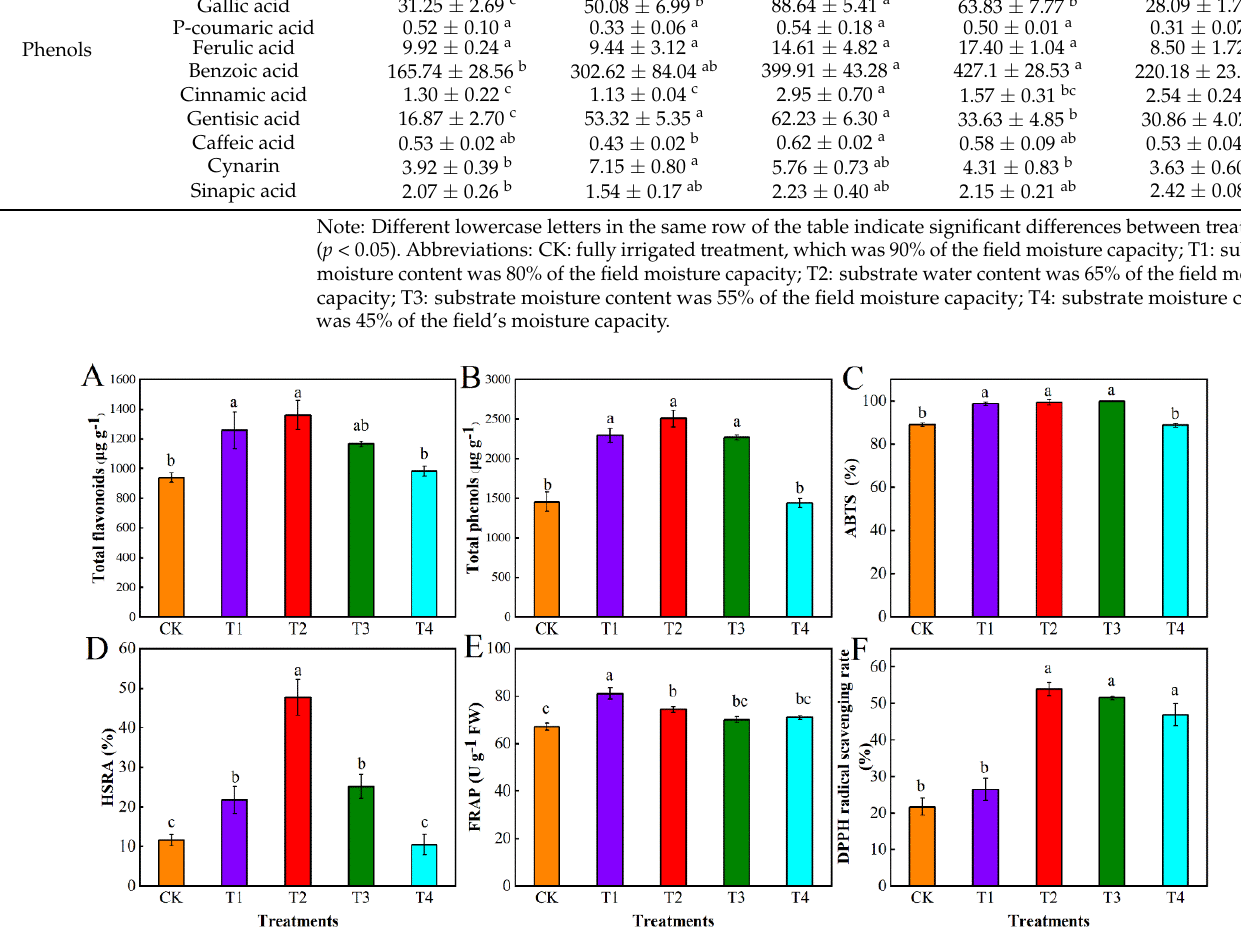
Figure 1. Effect of different levels of water deficit treatments on total flavonoids ( A ), total phenols ( B ), ABTS ( C ), HSRA ( D ), FRAP ( E ) and DPPH ( F ) of tomato fruits. ABTS: 2,2 ′‐ azino ‐ bis (3 ‐ ethylben ‐ zothiazoline ‐ 6 ‐ sulfonic acid; HSRA: hydroxyl radicals scavenging; FRAP: ferric ‐ reducing antioxi ‐ dant power; DPPH: 2,2 ‐ diphenyl ‐ 1 ‐ picrylhydrazyl radical scavenging activity. The abbreviations